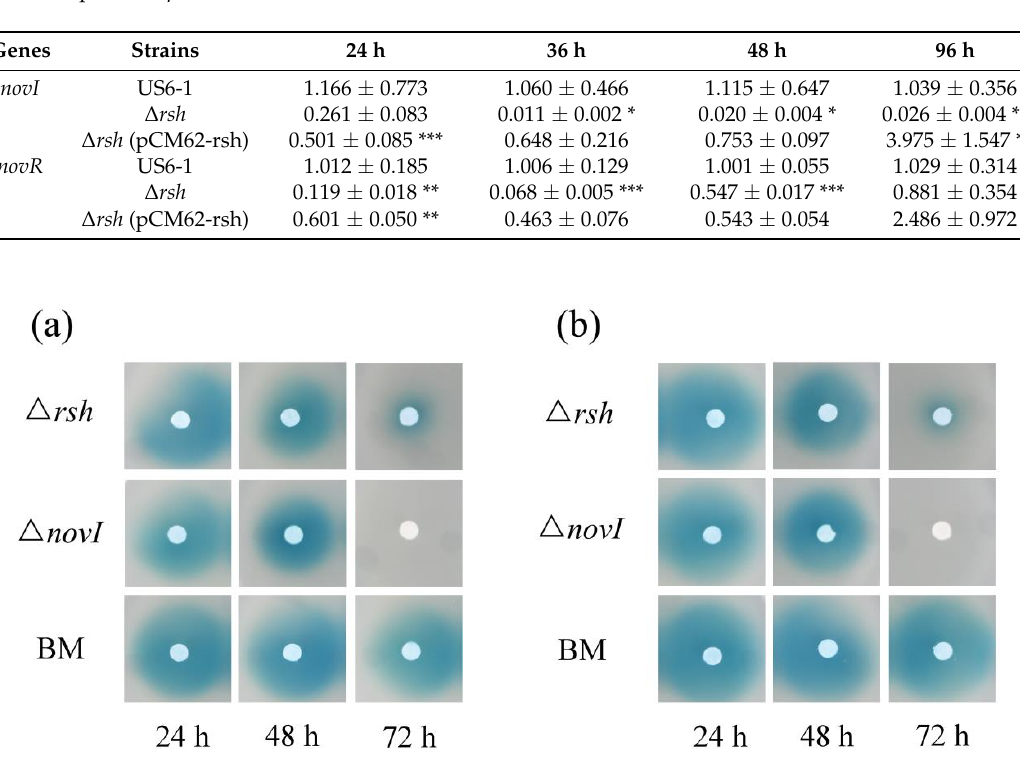
Table 1. Relative expression levels of novI and novR by quantitative reverse transcription polymerase chain reaction (qRT-PCR). RNA samples were extracted from bacterial cultures after 24 h, 36 h, 48 h and 72 h. The levels of gene expression in US6-1, ∆ rsh, ∆ rsh (pCM62-rsh) were normalized to 16S rRNA gene, and the relative levels in ∆ rsh and ∆ rsh (pCM62-rsh) to that in the wild-type strain (set as value of 1) were reported. Values shown are the average of biological triplicate experiments with standard deviations (mean ± standard deviation (SD)). “*” represents p < 0.05; “**” represents p < 0.01; “***” represents p < 0.001.